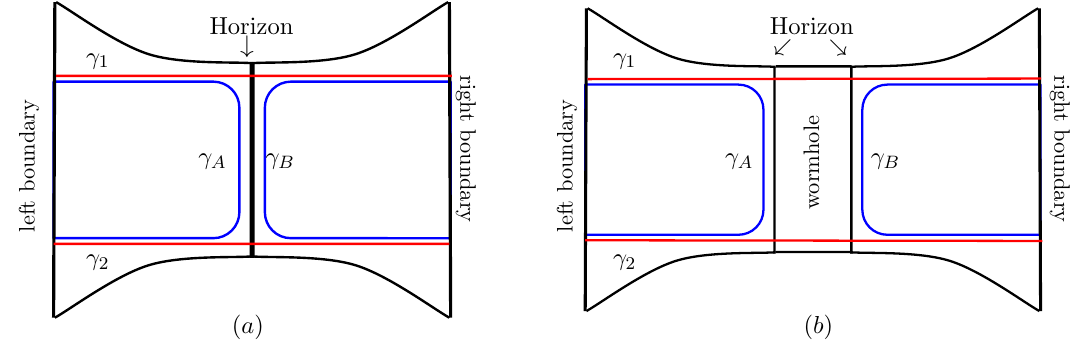
Figure 2 . Schematic representation of the t = 0 slice of (a) the unperturbed two-sided black brane geometry and (b) the two-sided black brane geometry in the presence of a shock wave. We assume that the shock wave is sent at some time t 0 < 0, therefore, it e(cid:11)ectively increases the size of the wormhole at t = 0. In both cases the blue curves represent the U-shaped extremal surfaces (cid:13) A (in the left side of the geometry) and (cid:13) B (in the right side of the geometry). The red curves represent extremal surfaces (cid:13) 1 and (cid:13) 2 connecting the two sides of the geometry. The extremal surface (cid:13) wormhole de(cid:12)ned in the text is given by the union of these two surfaces, (cid:13) wormhole = (cid:13) 1 [ (cid:13) 2 .